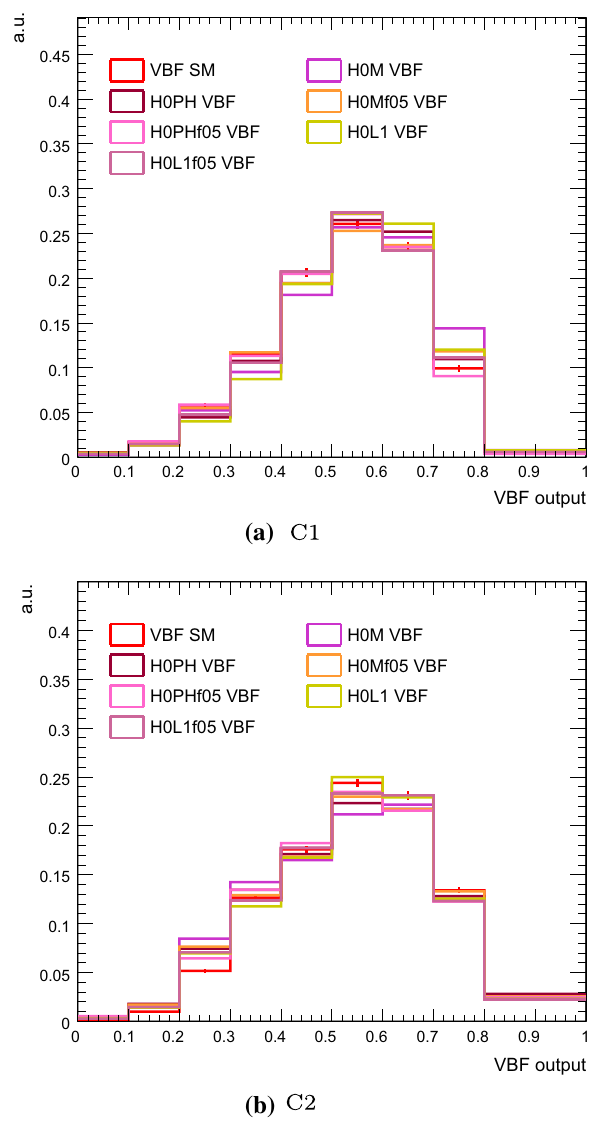
Fig. 5 Confusion matrix of the ADNN trained in C1 assuming a total integrated luminosity equal to 138 fb − 1 are illustrated. The following binning scheme is adopted: